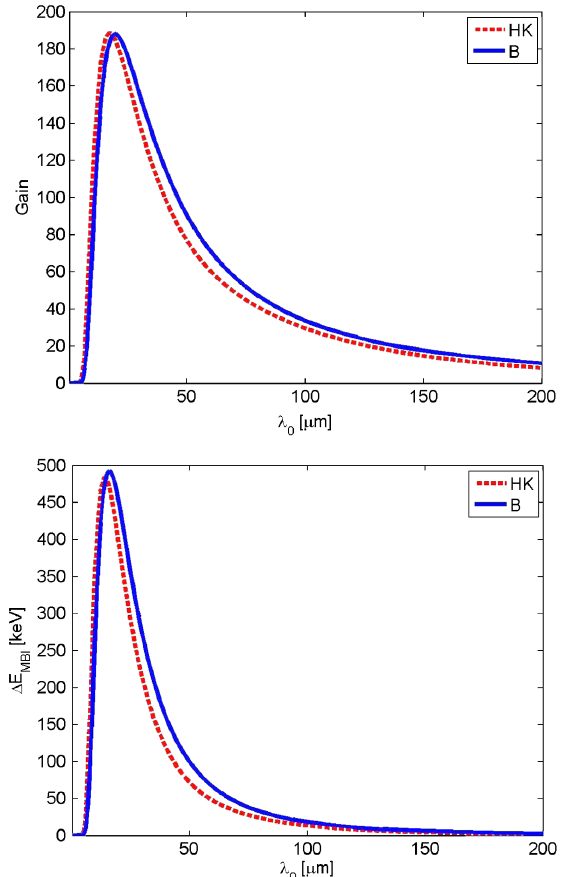
FIG. 3. Comparison of MBI gain (top) and energy modulation amplitude (bottom) at the end of the FERMI linac vs the initial density modulation wavelength. The two curves correspond to the separate predictions by the HK-model [22] (dashed line) and by the B-model [23] (solid line). For these curves, the laser heater induces 10 keV of rms energy spread before compression.